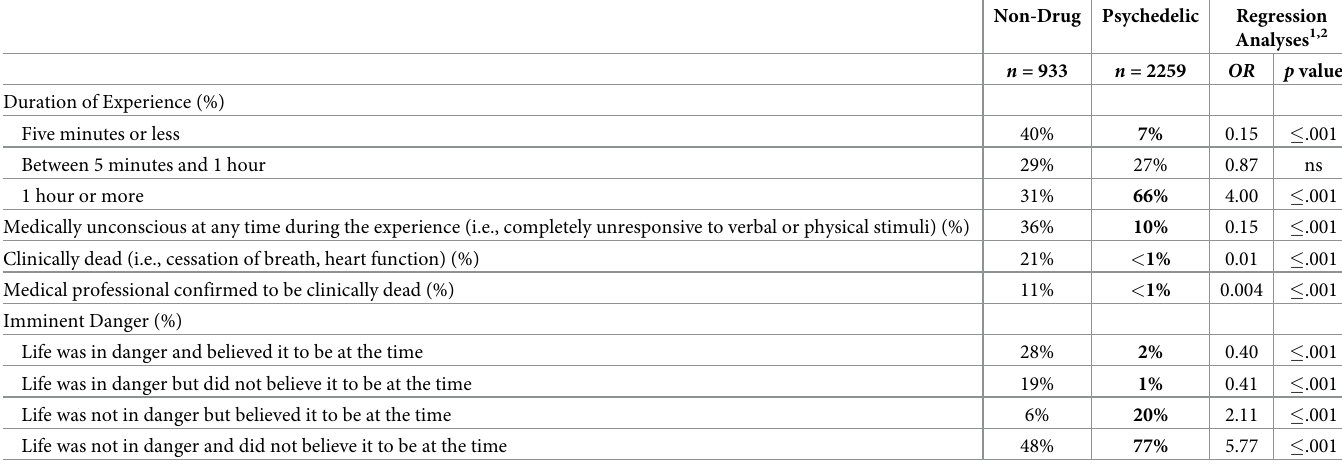
Table 3. Circumstances of the experience in the Non-Drug Group and the Psychedelic